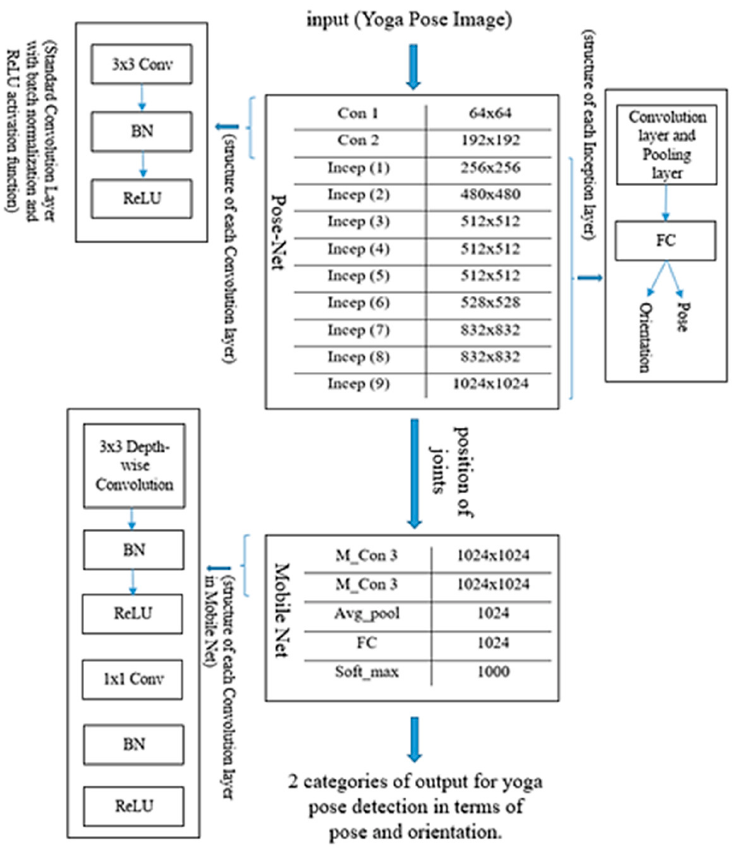
Figure 5. Block diagrammatic representation of the architectural flow of the proposed model.